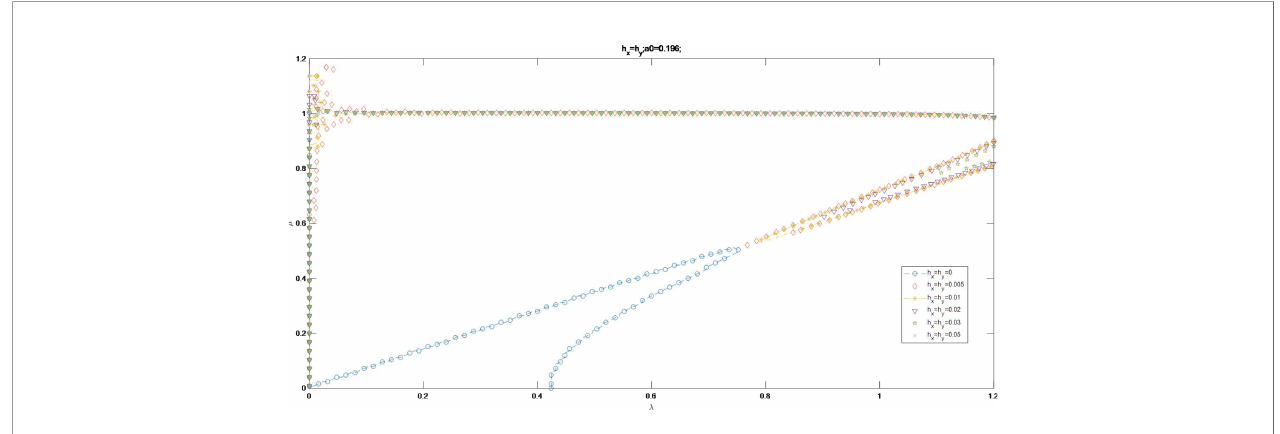
FIGURE 15 | Curves of Im W = 0 for a 0 = 0.196 and ∂ h ∂ x = ∂ h ∂ y